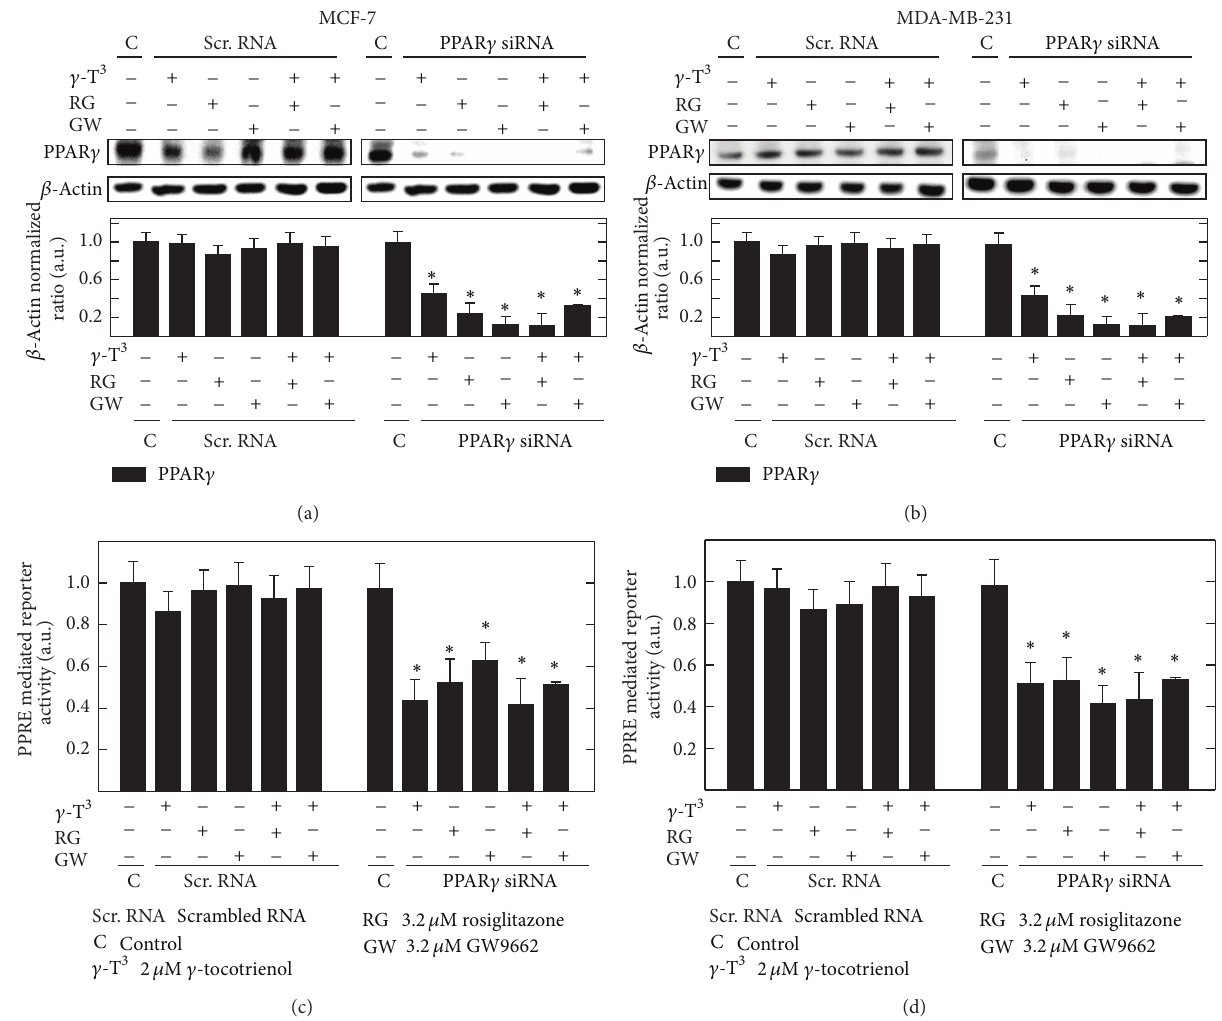
Figure 8: Western blot analysis and luciferase assay to determine effect of 𝛾 -tocotrienol, rosiglitazone, and GW9662 given alone or in combination on PPAR 𝛾 expression and activity in PPAR 𝛾 siRNA transfected MCF-7 and MDA-MB-231 cells. For Western blot